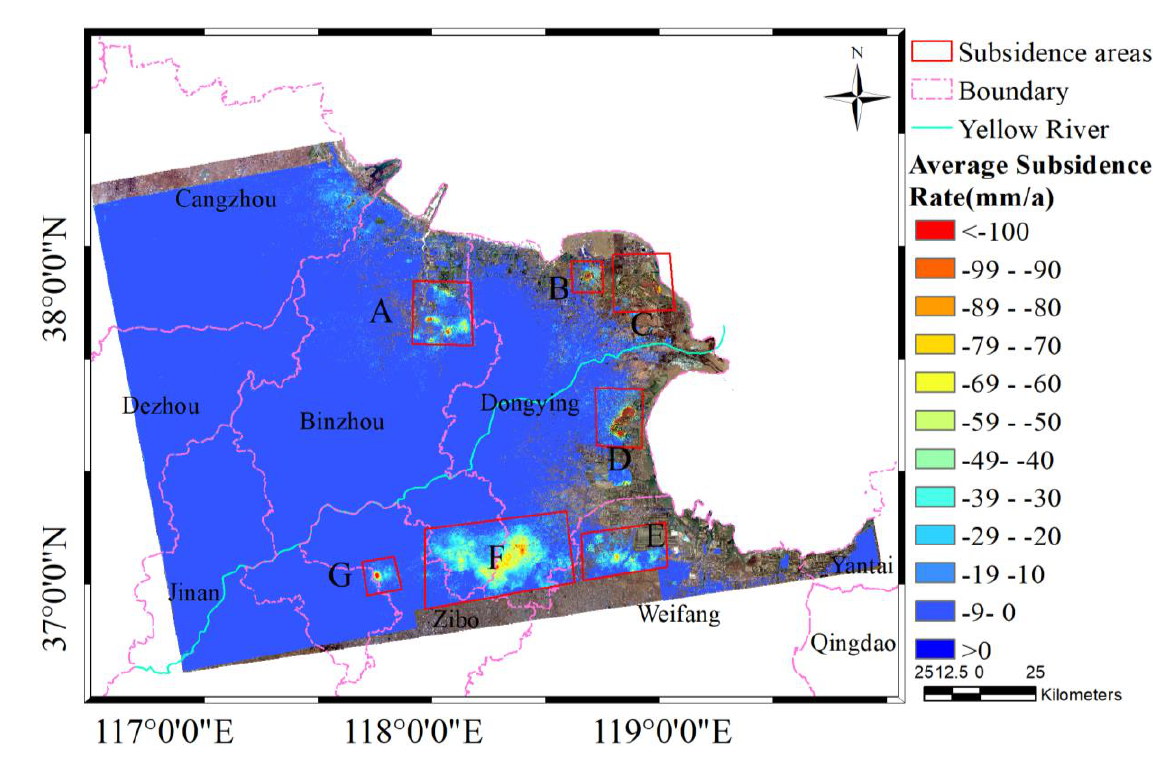
Figure.3 Average Subsidence Rate of Study Area from 2020 to 2022